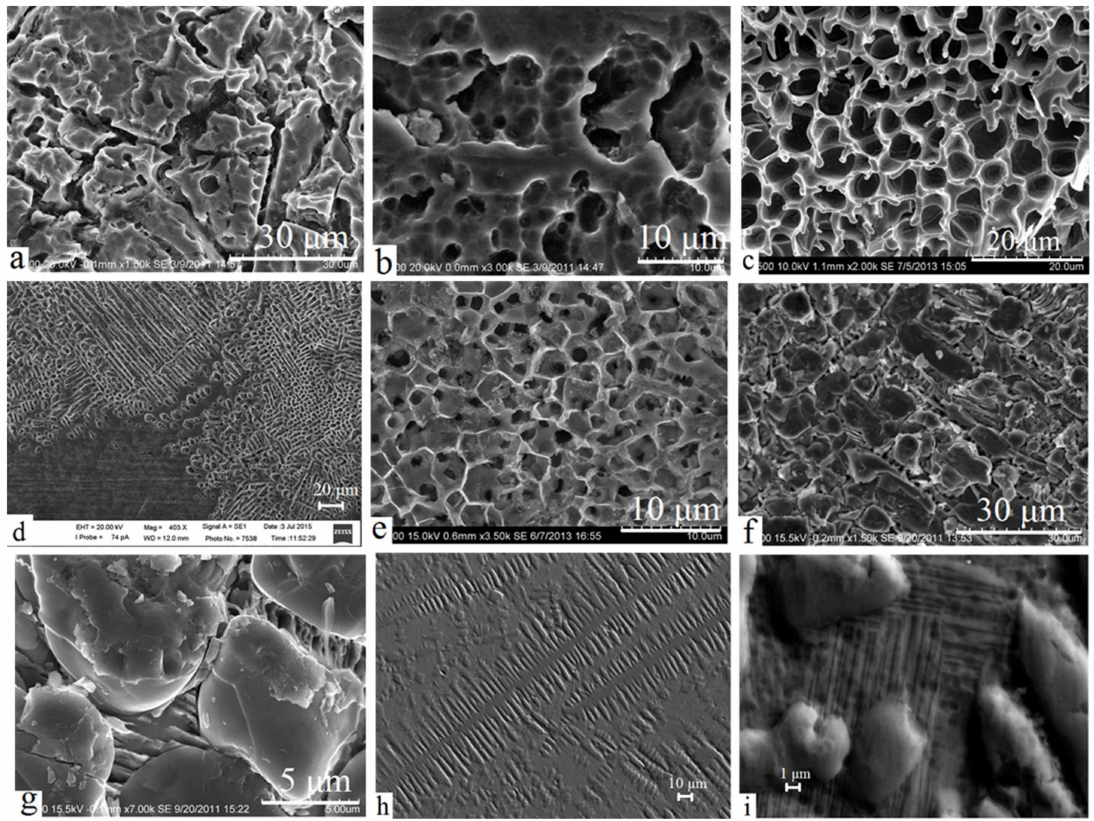
Figure 5. SEM images of the surface after: etching in Kroll’s reagent ( a , b ); etching in nitric acid ( c – e ) revealing of titanium matrix; etching in hydrochloric acid ( f , g ), fine polishing ( h , i ) revealing of TiC